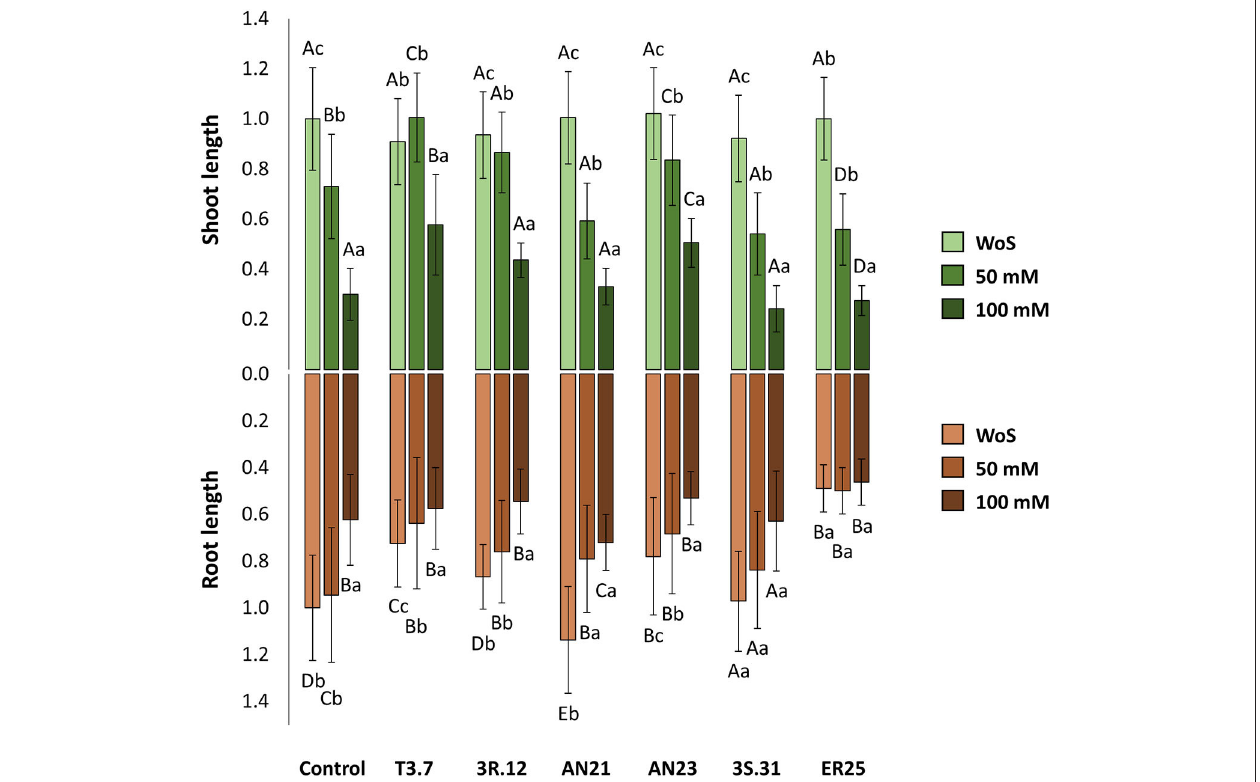
FIGURE 5 | Root and shoot length of 7-day old chia ( Salvia hispanica L.), seedlings grown on MS/2 agar medium, under different saline conditions: without salt (WoS), with 50 and 100mM NaCl. The seedlings were subjected to treatment with different bacterial strains: Control (without any bacteria), Kushneria sp. T3.7, Halomonas sp. 3R.12, Pseudomonas sp. AN21, Pseudomonas sp. AN23, Planomicrobium sp. 3S.31, and Pseudarthrobacter sp. ER25. Values were normalized for the control without bacteria and without salt. Capital letters refer to the comparison between different treatments in the same saline level, while lower case refers to the comparison of different salinity levels within the same bacterial treatment. Mean values sharing a common letter are not significantly different from each other ( p > 0.05).